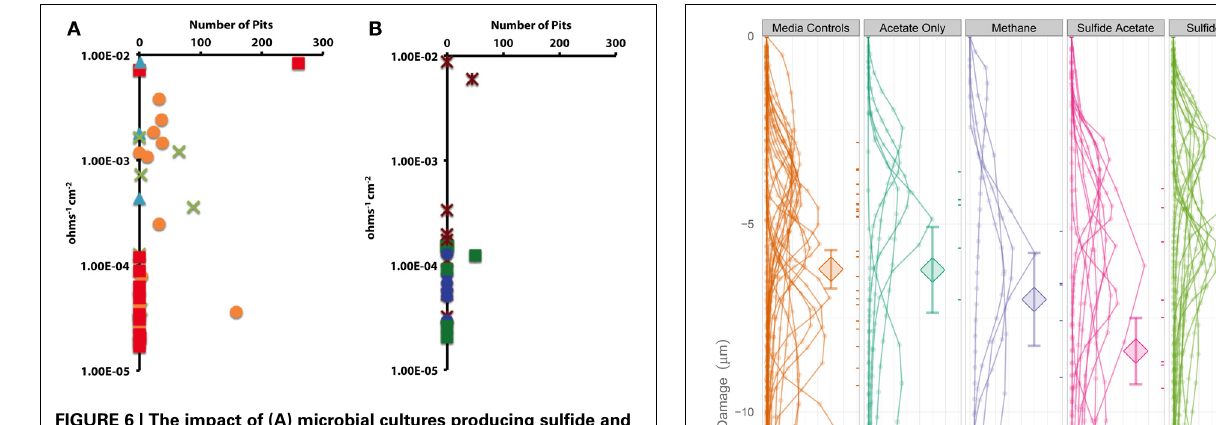
FIGURE 6 | The impact of (A) microbial cultures producing sulfide and acetate ( ), sulfide only ( ), acetate only ( ), and methane ( ) on localized corrosion. Compared to (B) uninoculated medium controls amended with crotonate ( ), lactate ( ), or no VFA ( ).